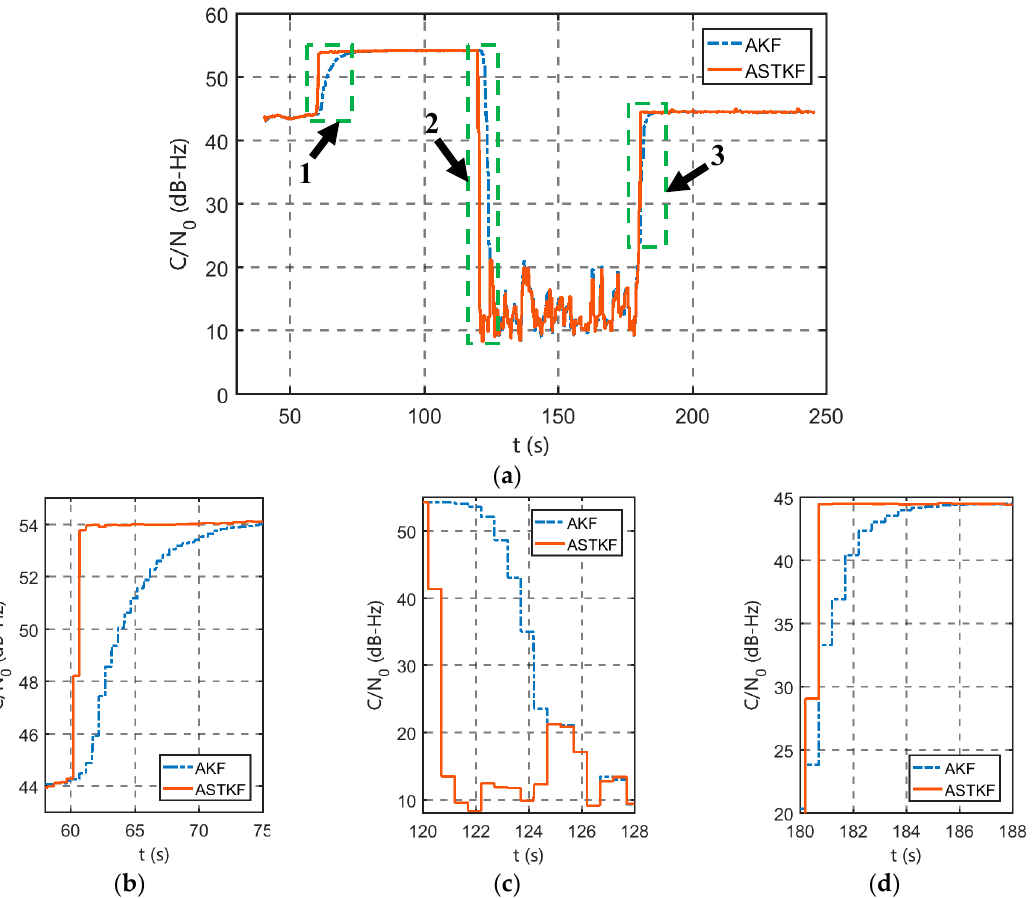
Figure 6. Comparison of the estimation results in a C / N 0 mutation environment (0.5 s averaging time): ( a ) a global figure; ( b ) a zoomed-in view of part 1; ( c ) a zoomed-in view of part 2; and ( d ) a zoomed-in view of part 3.